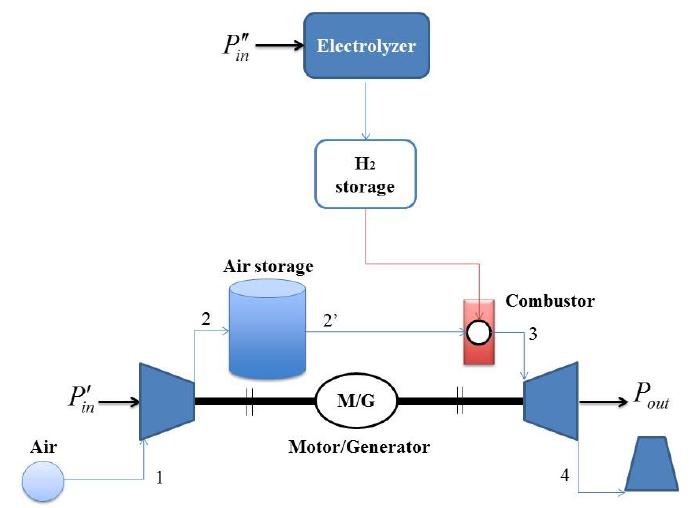
Figure 1. Schematic representation of the simple hybrid energy storage system .